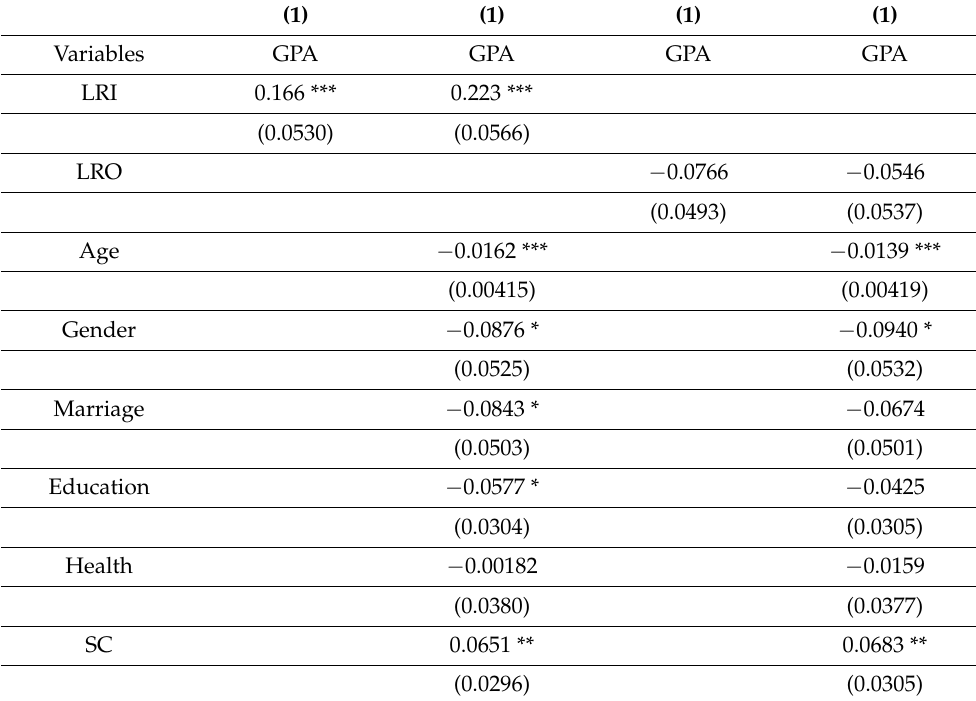
Table 3. Regression results of the impact of land transfer on